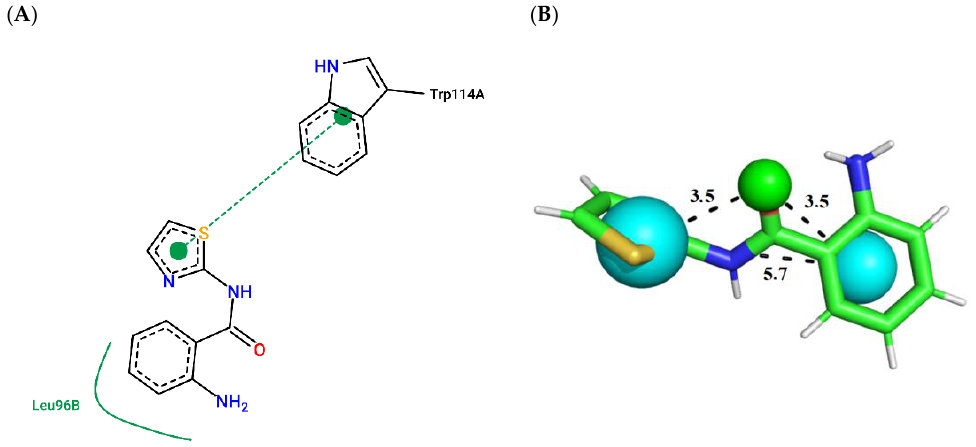
Figure 6. ( A ) Interaction map of ZINC698 in the Poseview software generated by the Aaeg OBP1 binding site (ChemPLP = 59.81). ( B ) ZINC698 superimposed on the model pharmacophore Aaeg OBP1 (QFIT = 83.45). Cyan spheres represent hydrophobic centers (HY) and green spheres represent hydrogen bond donors (HBD). The size of the spheres varies according to the radius tolerance calculated by GALAHAD™. All distances were measured in angstroms. (Legend: Ligand: Carbons are represented in green, nitrogen in blue and oxygen in red).